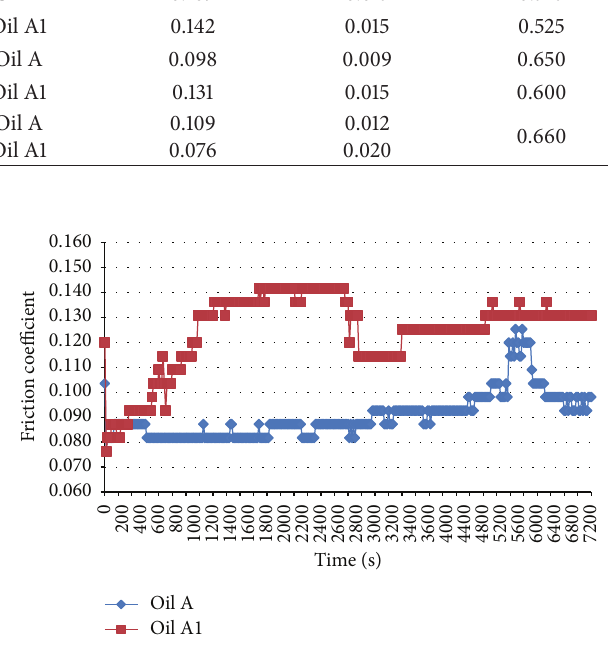
Figure 3: Friction coefficient variation with time using new balls (tests 3 and